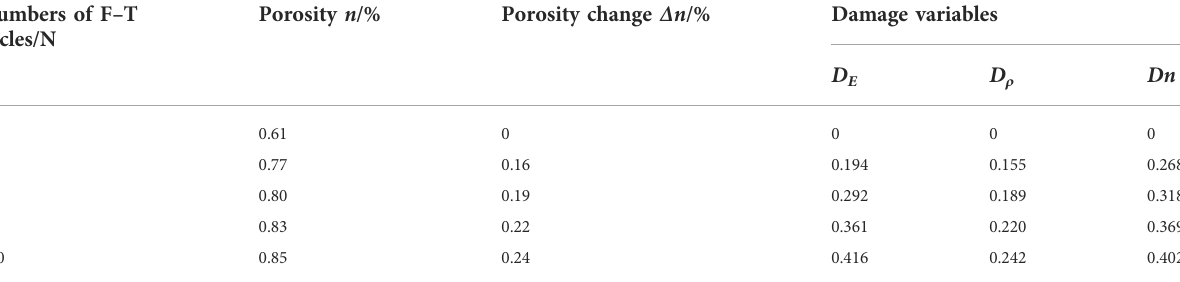
TABLE 4 Porosity change and damage variables of granite samples for different F – T cycles.